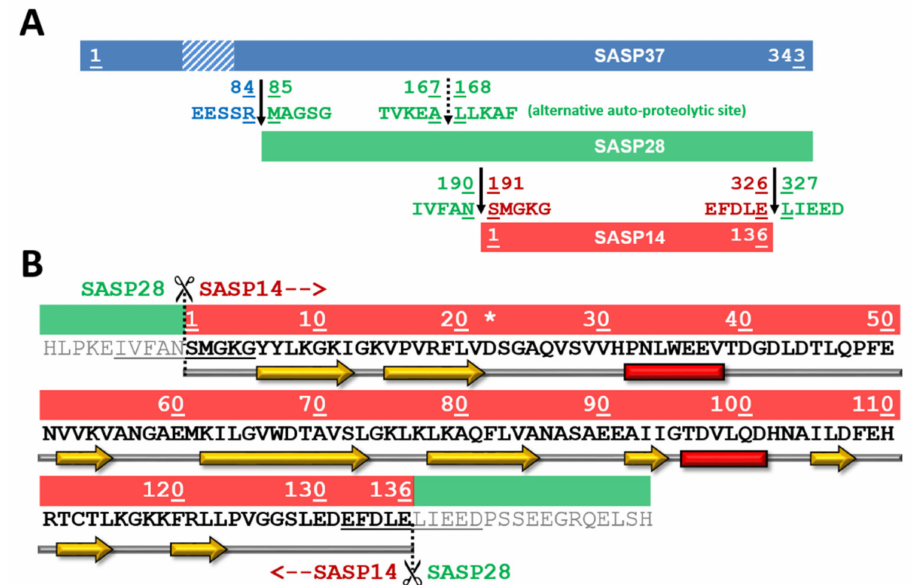
Figure1. SchematicrepresentationofSASP37, SASP28, andSASP14forms. ( A )Schematicrepresentation of SASP37, SASP28, and SASP14 forms is shown. A transmembrane domain (F56-E77) at the N-terminal region of SASP37 is shown by a dashed box based on literature data [1,2]). SASP37 numbering was used to label boundaries of di ff erent ASPRV1 forms and processing site sequences. ( B ) Sequence and predicted secondary structure is shown for SASP14, using SASP14 numbering (S1-E136). Asterisk indicates the catalytic aspartate of the consensus active site motif. The N- and C-terminal processing sites are underlined [1]. Predicted secondary structure is also indicated, yellow arrows indicate β -strands, while red boxes indicate α